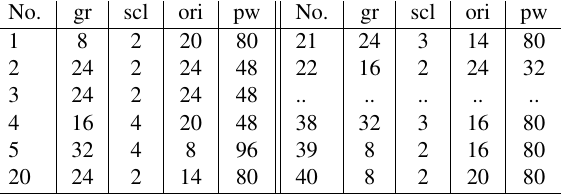
Table 4: Excerpt of Gabor parameters for highest and lowest sim- ilarity measure for the Rock am Ring